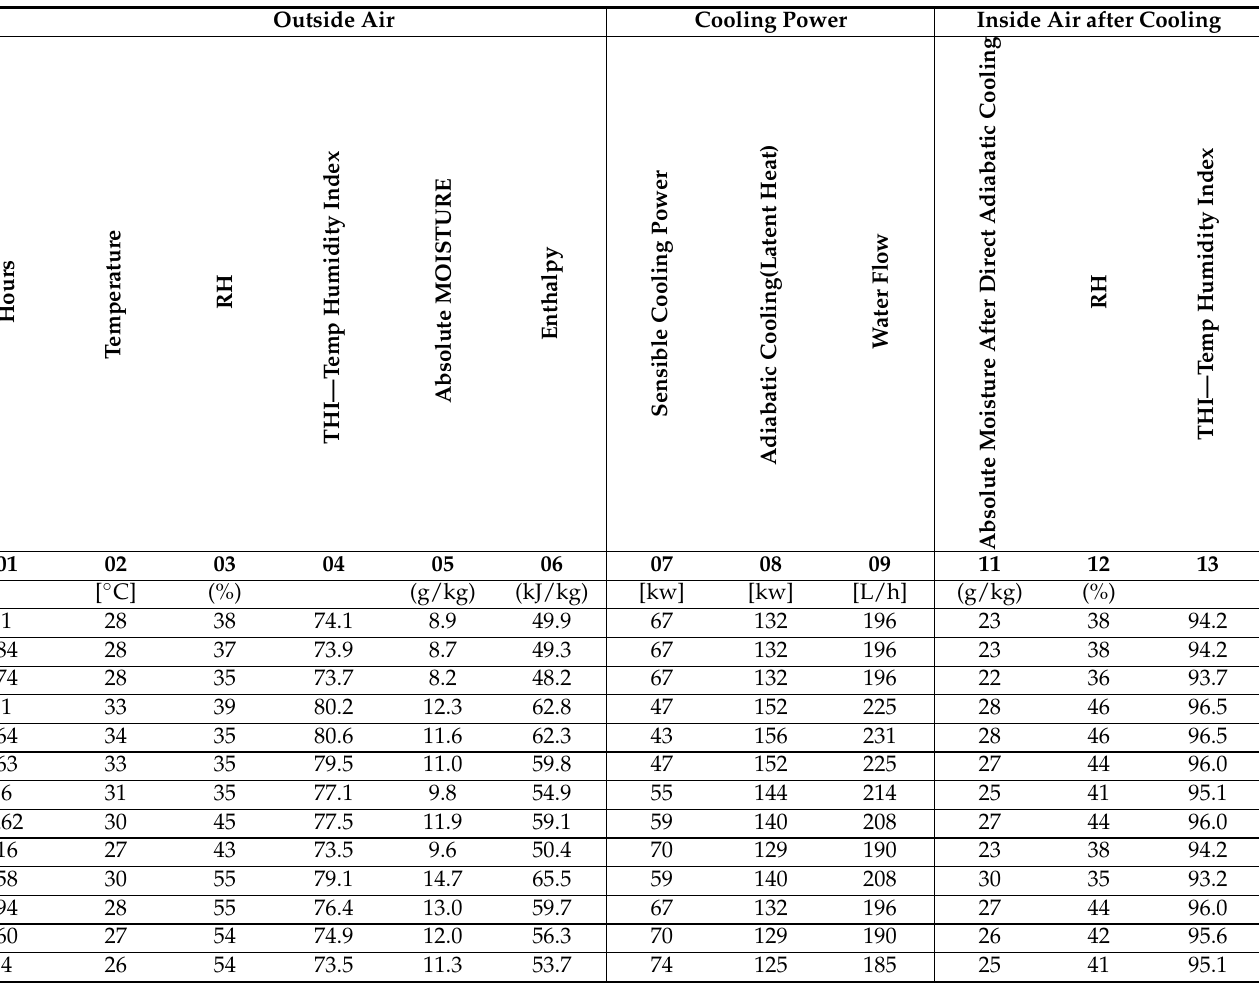
Table 9. Direct Adiabatic cooling power calculated for cooling air flow of 12,350 m 3 /h (2 fans